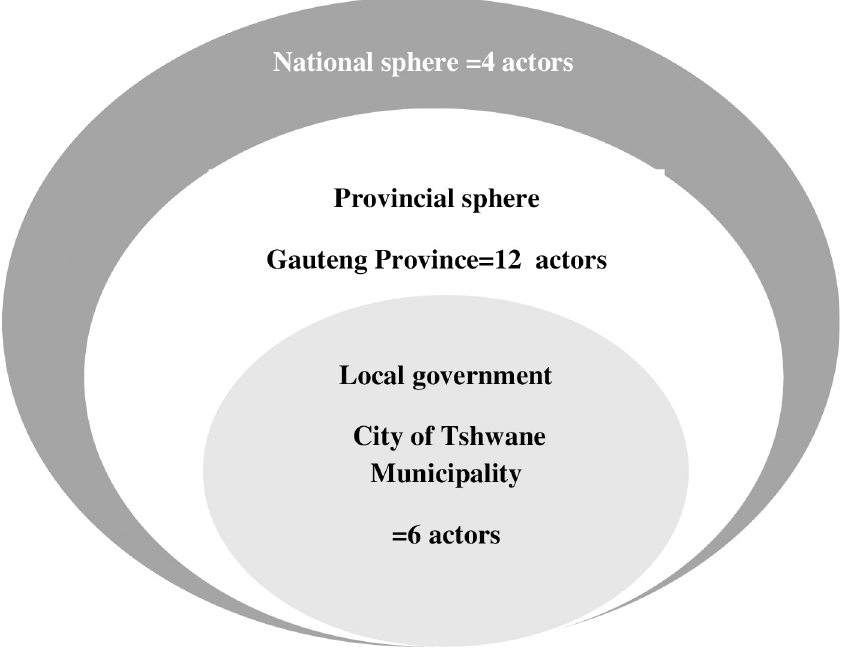
Fig 1. Overview of Gauteng province network.